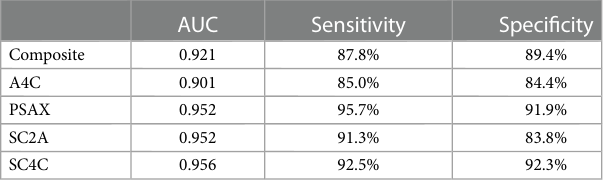
TABLE 2 Model performance for ASD detection in different views.